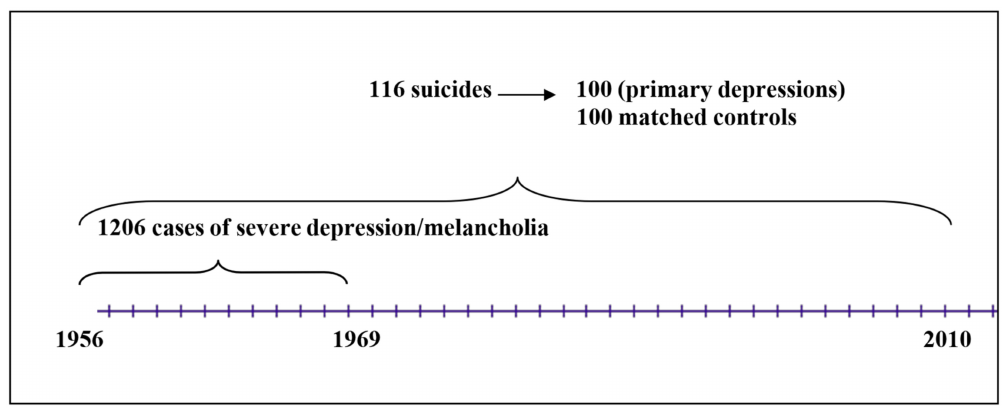
Figure 1. Flow diagram for the sample of patients with severe depression admitted to the Department of Psychiatry, Lund University